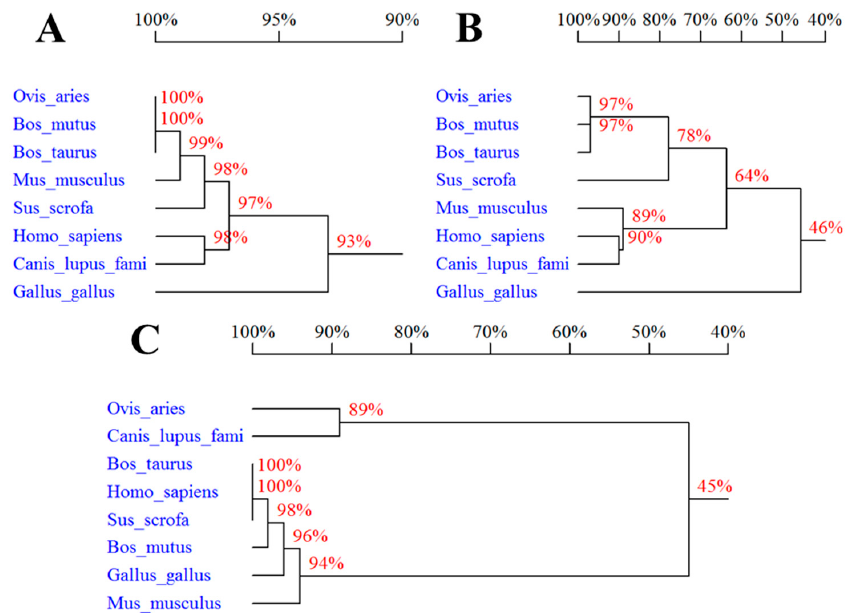
Figure 1. Percentage of sequences homology of SPP1 ( A ), LAP3 ( B ), and LCORL ( C ): Bos taurus